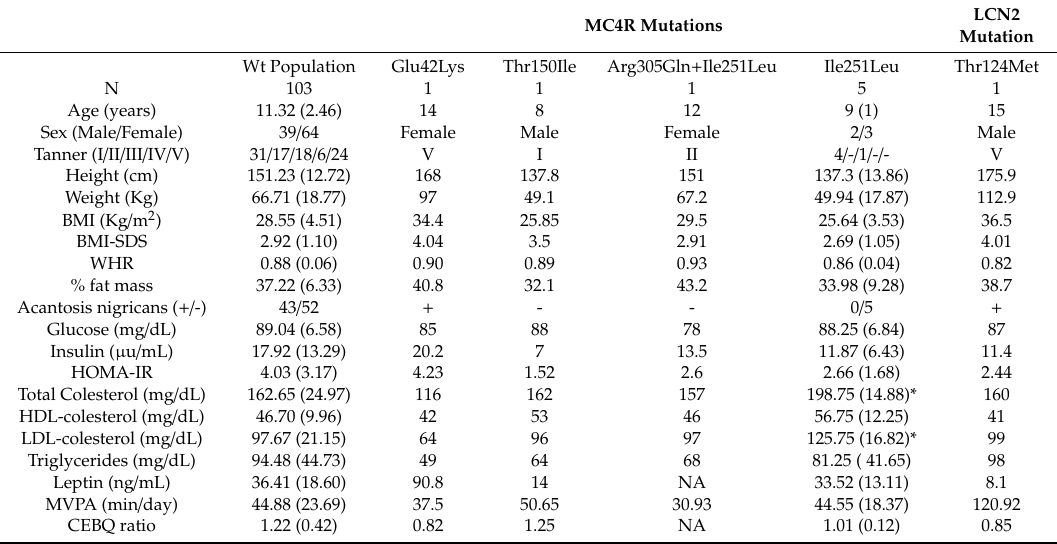
Table 2. Baseline characteristics of heterozygous MC4R and LCN2 variant carriers and wild type Spanish children with abdominal obesity.